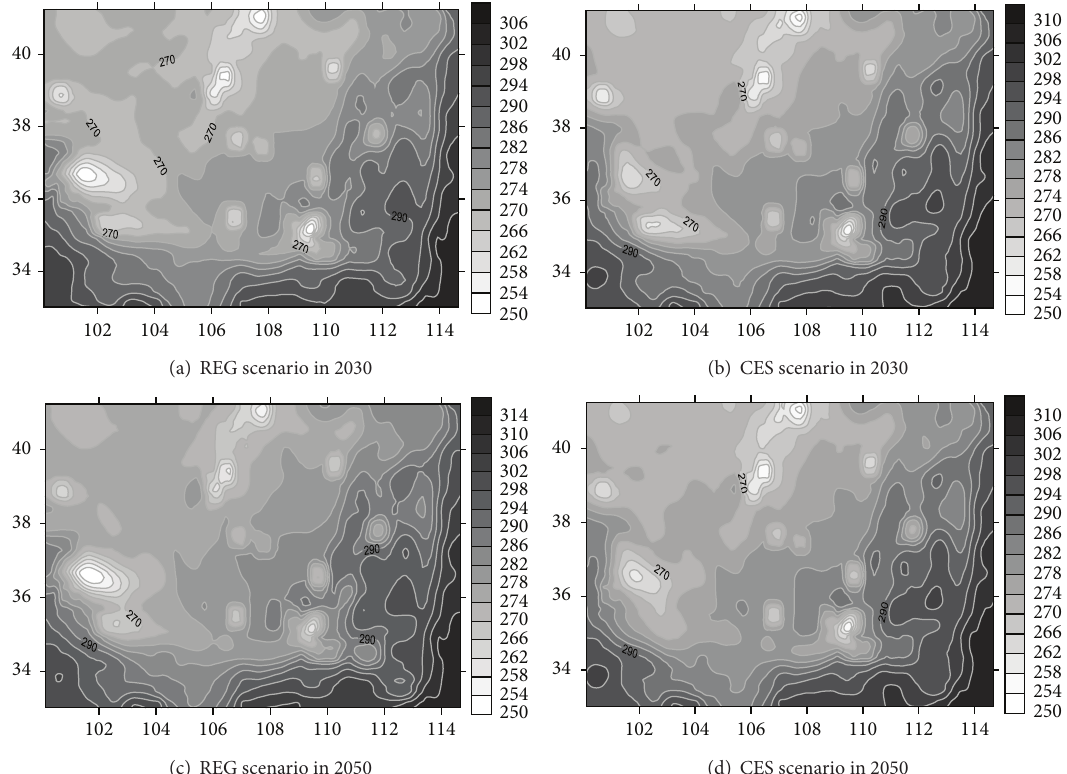
Figure 5: Downward short wave radiation changes under different scenarios in 2030 and 2050 in the semiarid grassland area of China (unit: W/m 2